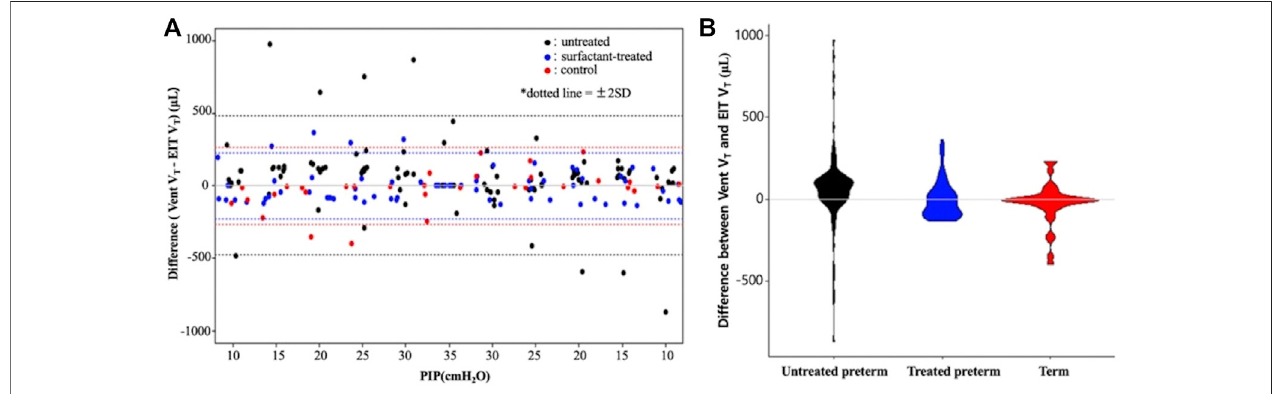
FIGURE 4 | A Bland – Altman plot (A) and violin plot (B) showing differences between the ventilator and EIT with the 95% limits of agreement. PIP, peak inspiratory pressure; Vent V T, ventilator tidal volume; EIT V T , EIT tidal